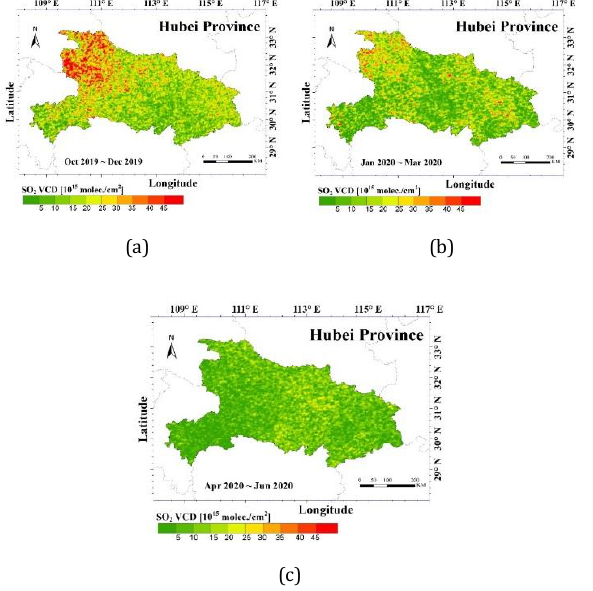
Figure 3: The spatial distribution of the SO 2 VCD (a) three month before COVID-19 Outbreak; (b) During the COVID-19 Outbreak and lockdown; (c) after releasing the lockdown